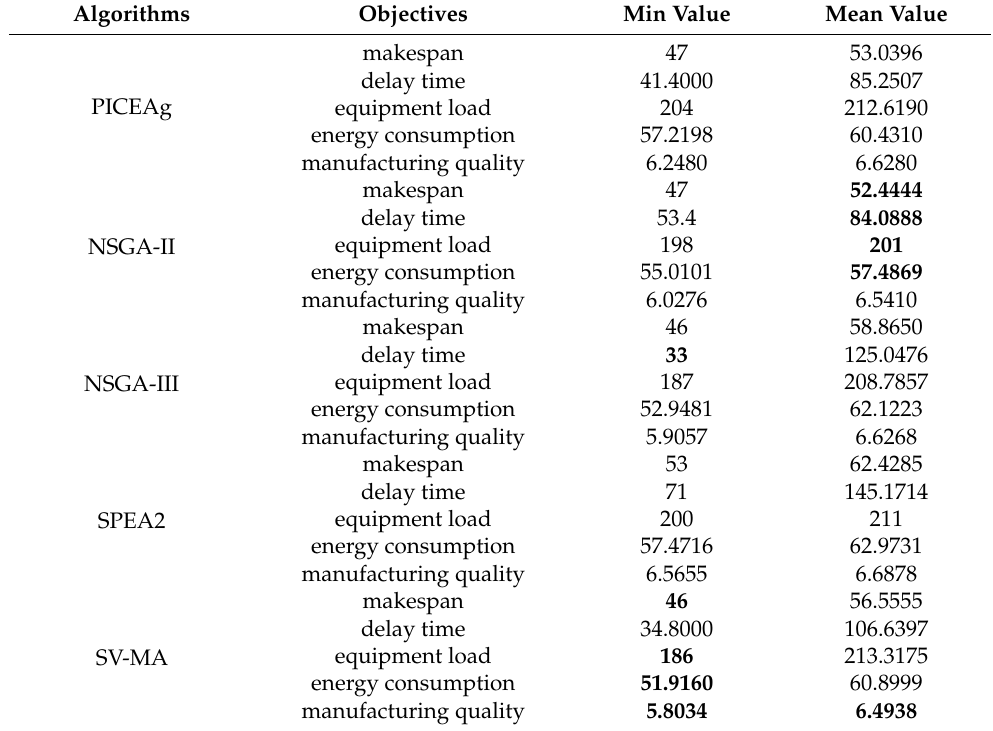
Table 6. Statistical values of non-dominated solution set.